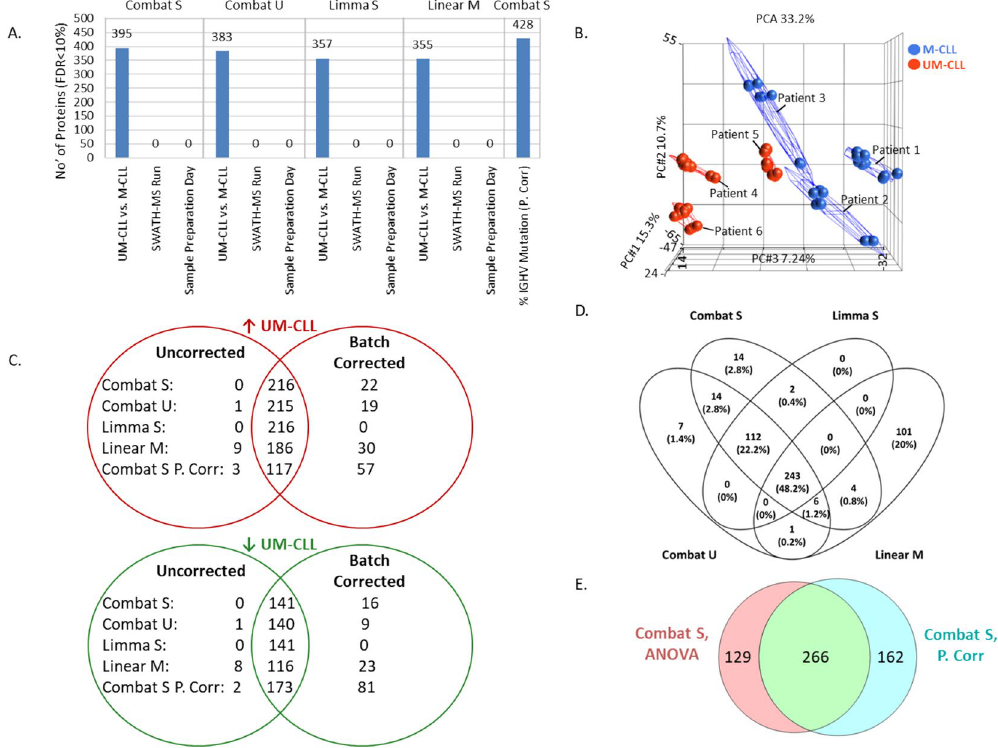
Figure 3. Assessment of methods to remove batch effects in SWATH-MS data. ( A ) Results of ANOVA, limma and partial correlation analysis (P. Corr) on SWATH-MS data that has been batch-corrected using either Combat S, Combat U, limma S or limma with batch information incorporated into the linear model design (linear M) methods. The graph shows the number of differentially expressed proteins (≤ 10% FDR) found to be associated with technical (sample preparation day and SWATH-MS run) or biological (IGHV subgroup (UM-CLL/M-CLL) and % of IGHV mutation) variables. ( B ) PCA plot of SWATH-MS data after processing using Combat S showing clustering based on patient samples (1–6) and on UM-CLL (red) or M-CLL (blue) IGHV mutational status. ( C ) Overlap of proteins found to be significantly associated with IGHV mutation (FDR < 10%) in the SWATH-MS data before (uncorrected) and after batch correction. ( D ) Venn diagram showing overlaps of differentially expressed proteins (UM-CLL/M-CLL) (FDR < 10%) in data which has been batch corrected using Combat S, Combat U, limma or linear M. ( E ) Venn diagram showing overlap of proteins found to be differentially expressed between UM-CLL and M-CLL by ANOVA (FDR < 10%) and significant correlation to percentage of IGHV mutation by partial correlation analysis (P. Corr) (FDR < 10%), after Combat S batch